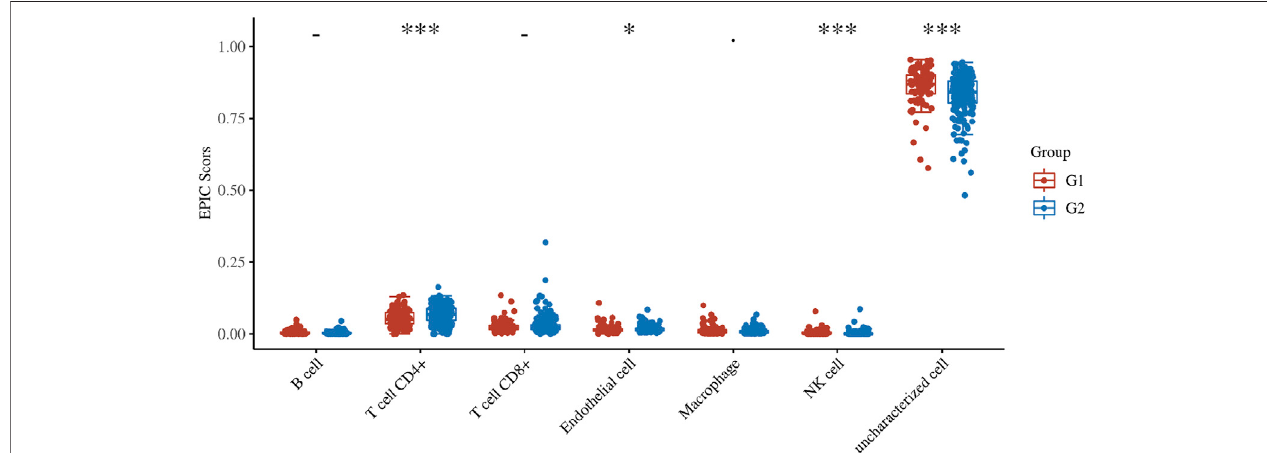
FIGURE4| Immunescore.ThescoredistributionofDNAdamagerepairrelatedgenesintwosubgroups(F1andF2),thehorizontalaxisrepresentsdifferentsample groups, the longitudinal axis represents the gene expression distribution, the different colors represent different groups, and the upper left corner represents the